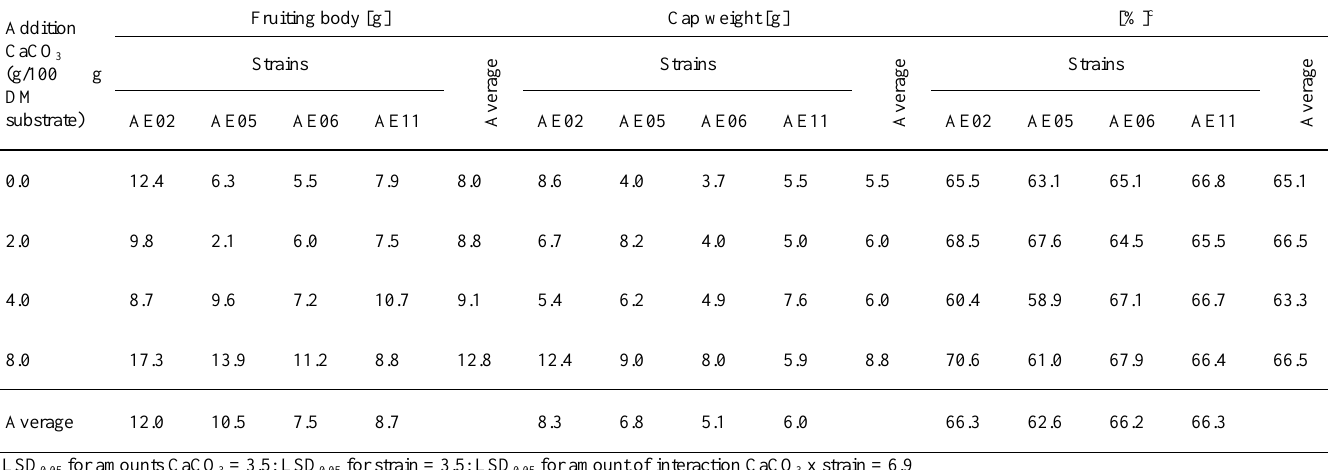
Table 3. Influence of addition of CaCO 3 on carpophores and cap weight and percent of share of carpophore weight and weight of whole fruiting bodies [g]